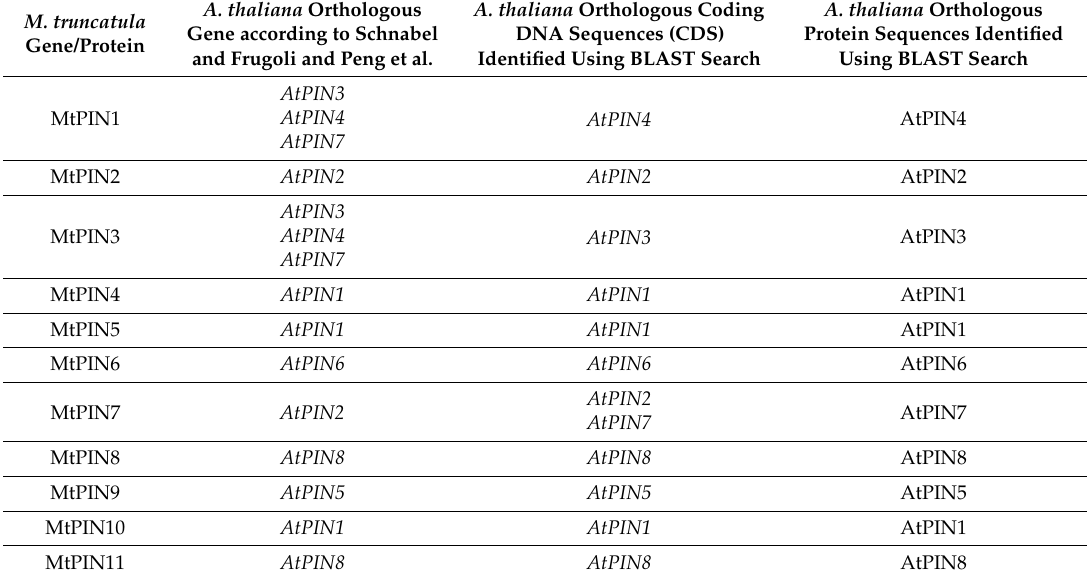
Table 1. The relationship of M. truncatula PINs and their A. thaliana orthologs according to Schnabel and Frugoli and Peng et al. [18,19] or identified using BLAST